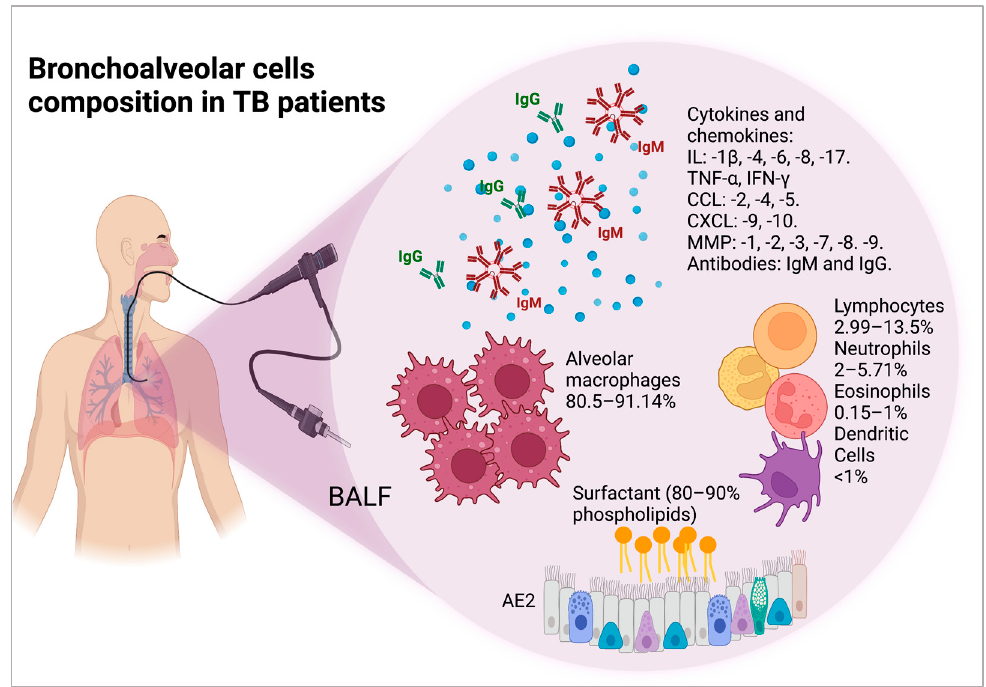
Figure 1. A complex composition of cells of the innate and adaptive immune system is found in bronchoalveolar lavage fluid (BALF) obtained from TB patients, 90% of which comprises alveolar macrophages. Other components found in BALF include surfactants, cytokines, chemokines, and metalloproteinases (created with BioRender.com).